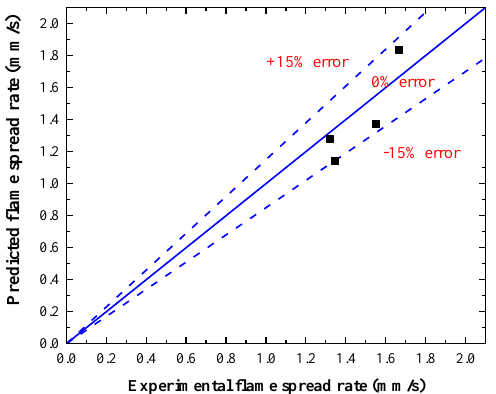
Figure 6. Comparison between predicted and experimental flame spread rate.